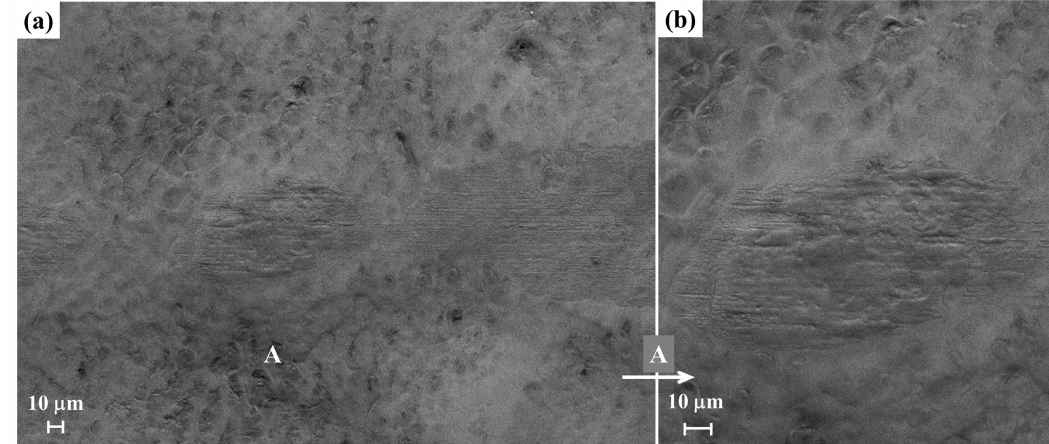
Figure 8. SEM wear topography of HCPEB-treated Ta coating after sliding in pure JP-10 against a Si 3 N 4 ball under 2.0 GPa at room temperature in ambient atmosphere: ( a ) overview SEM image; ( b ) high-magnification SEM image of protrusion A in ( a